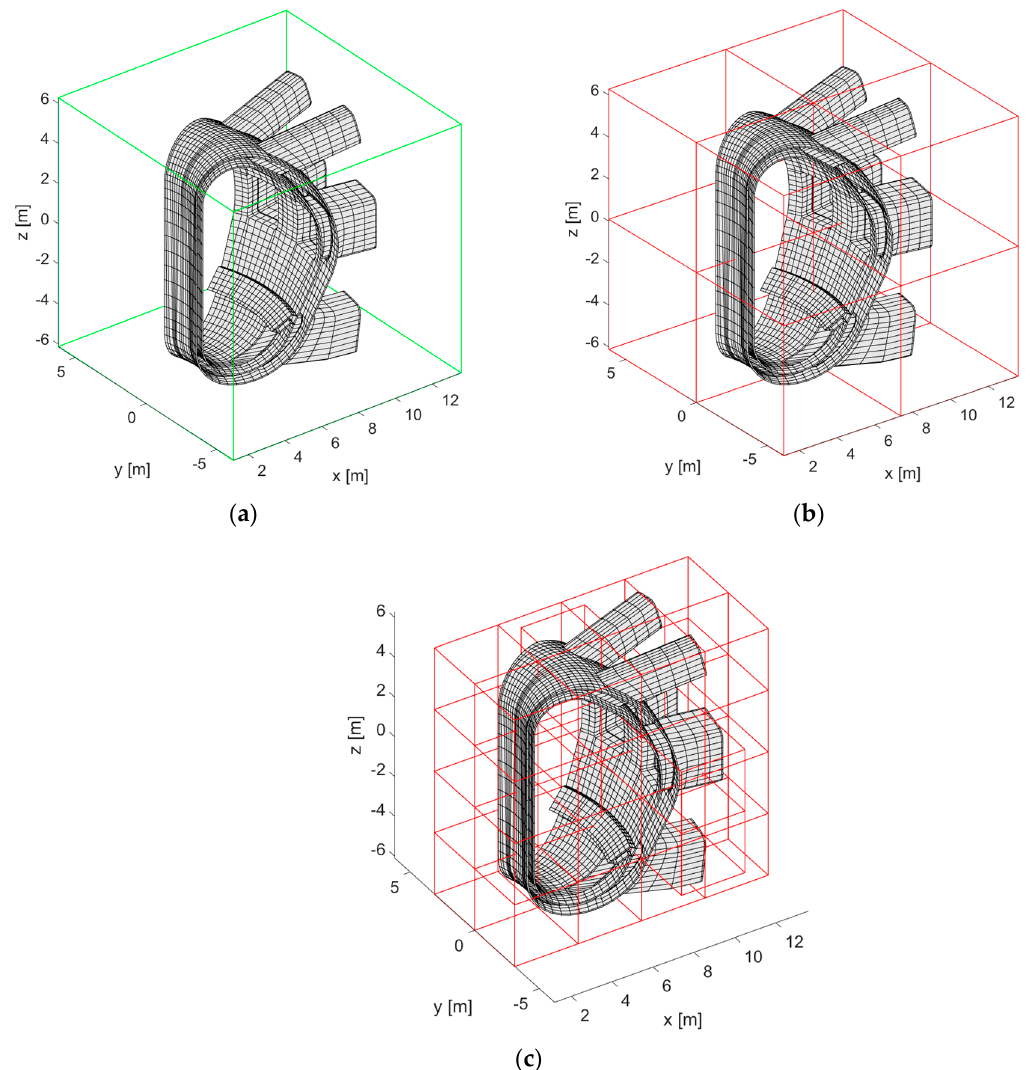
Figure 3. Boxes Generation algorithm. ( a ) The b0 at level = 0. ( b ) The eight boxes (children) generated at level equal 1 by subdivision of the box b0 . ( c ) Shows the third level subdivision. Note that empty boxes are deleted.